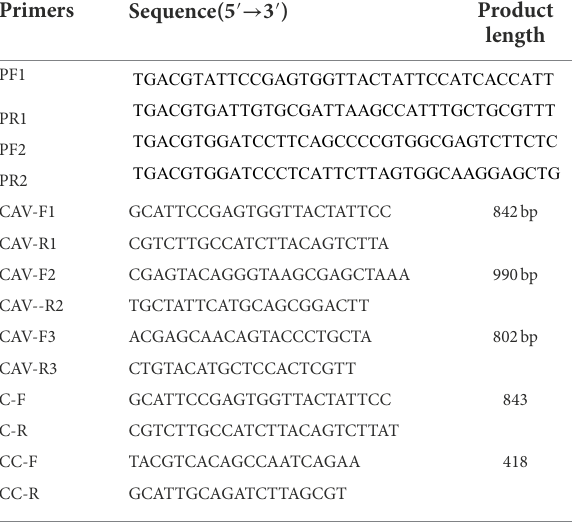
TABLE 1 Primers used for CIAV amplification and